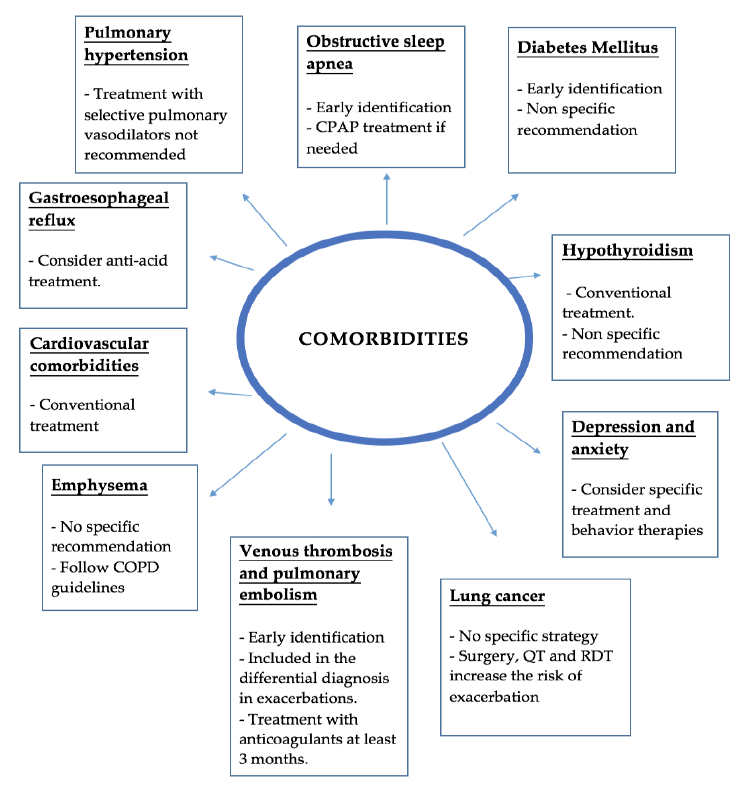
Figure 1. Summary of comorbidities and complications. CPAP—Continuous Positive Airway Pressure; COPD—Chronic Obstructive Pulmonary Disease; QT—Chemotherapy;